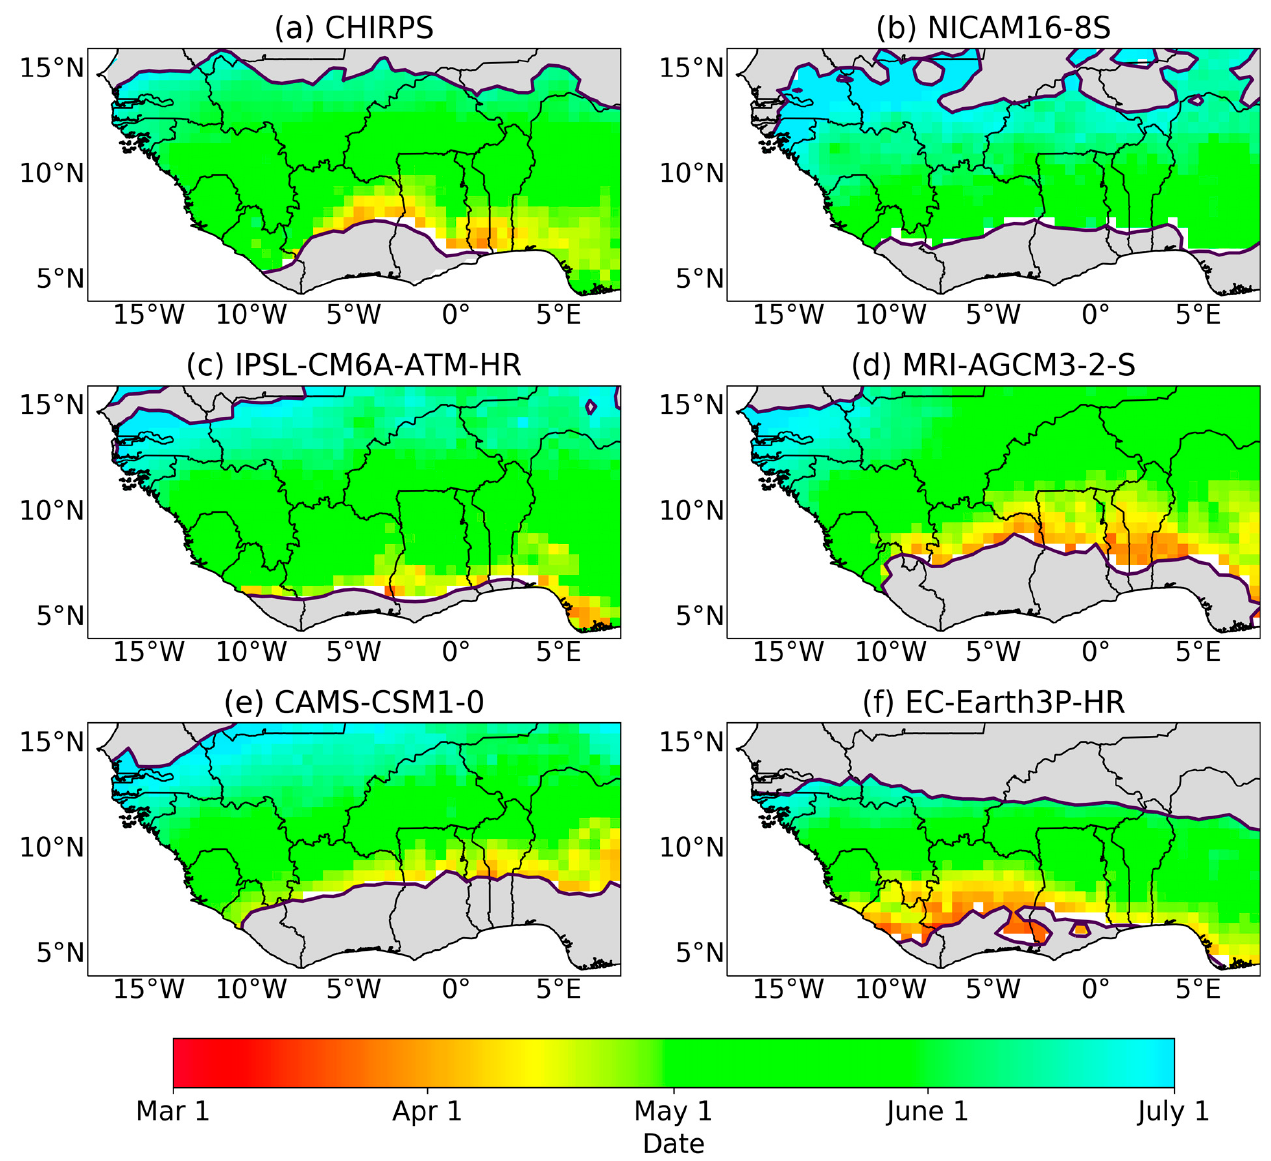
Figure 2. Mean onset date for unimodal regime regions for all data sets. Dark grey at the south indicates regions with bimodal regimes and grey at the north indicates dry regions.